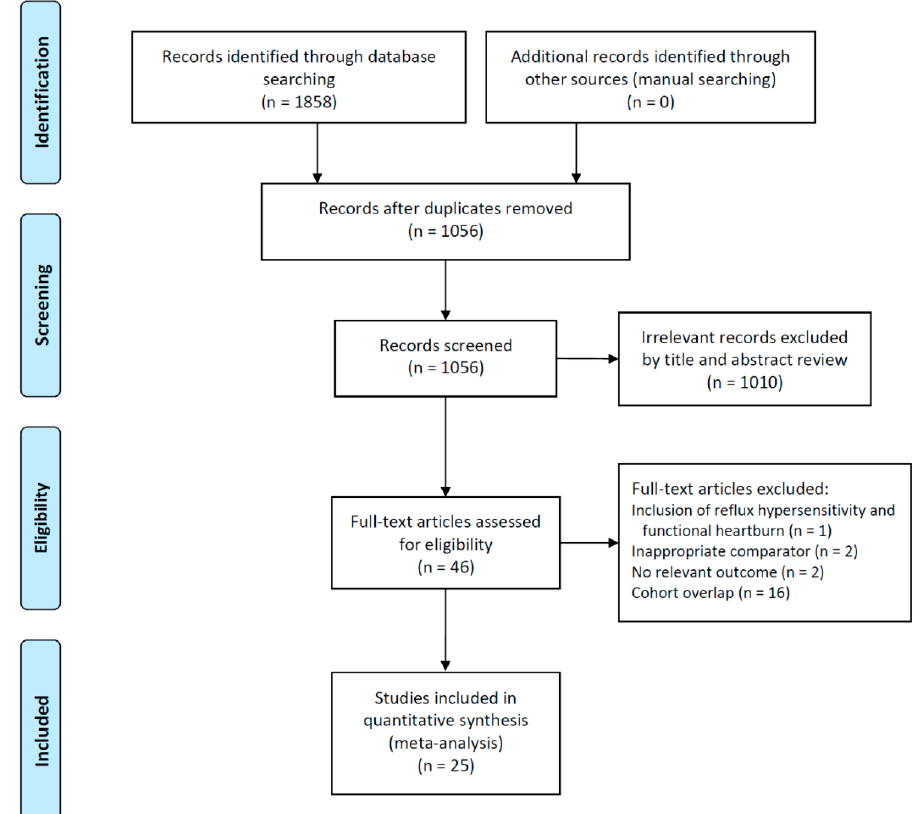
Figure 1. Flow diagram of the studies included in the meta-analysis.